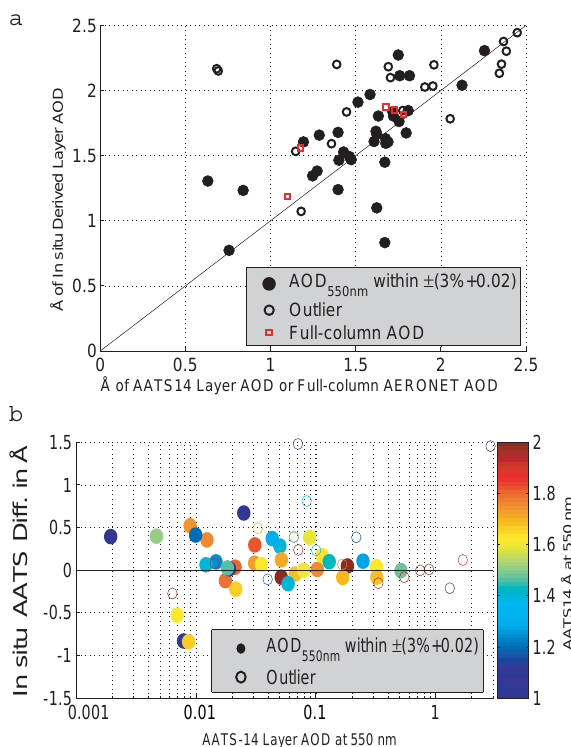
Fig. 7. (a) ˚Angstr¨om exponent of the layer AODs derived from the in situ instruments (determined via least square fit on log scales at 450, 550 and 700nm, y-axis) and AATS-14 (the value at 550nm of the second polynomial fit, x-axis). The filled markers indicate the vertical profiles that see agreement within 3%+0.02 between the layer AODs. Other profiles are marked with empty circles. The red squares compare the 440/675nm ˚Angstr¨om exponent of full- column AERONET AOD with the in situ ˚Angstr¨om exponent for the AERONET fly-over cases. (b) The difference in the in-situ and AATS-14 ˚Angstr¨om exponents, compared against the AATS- 14 layer AOD 550